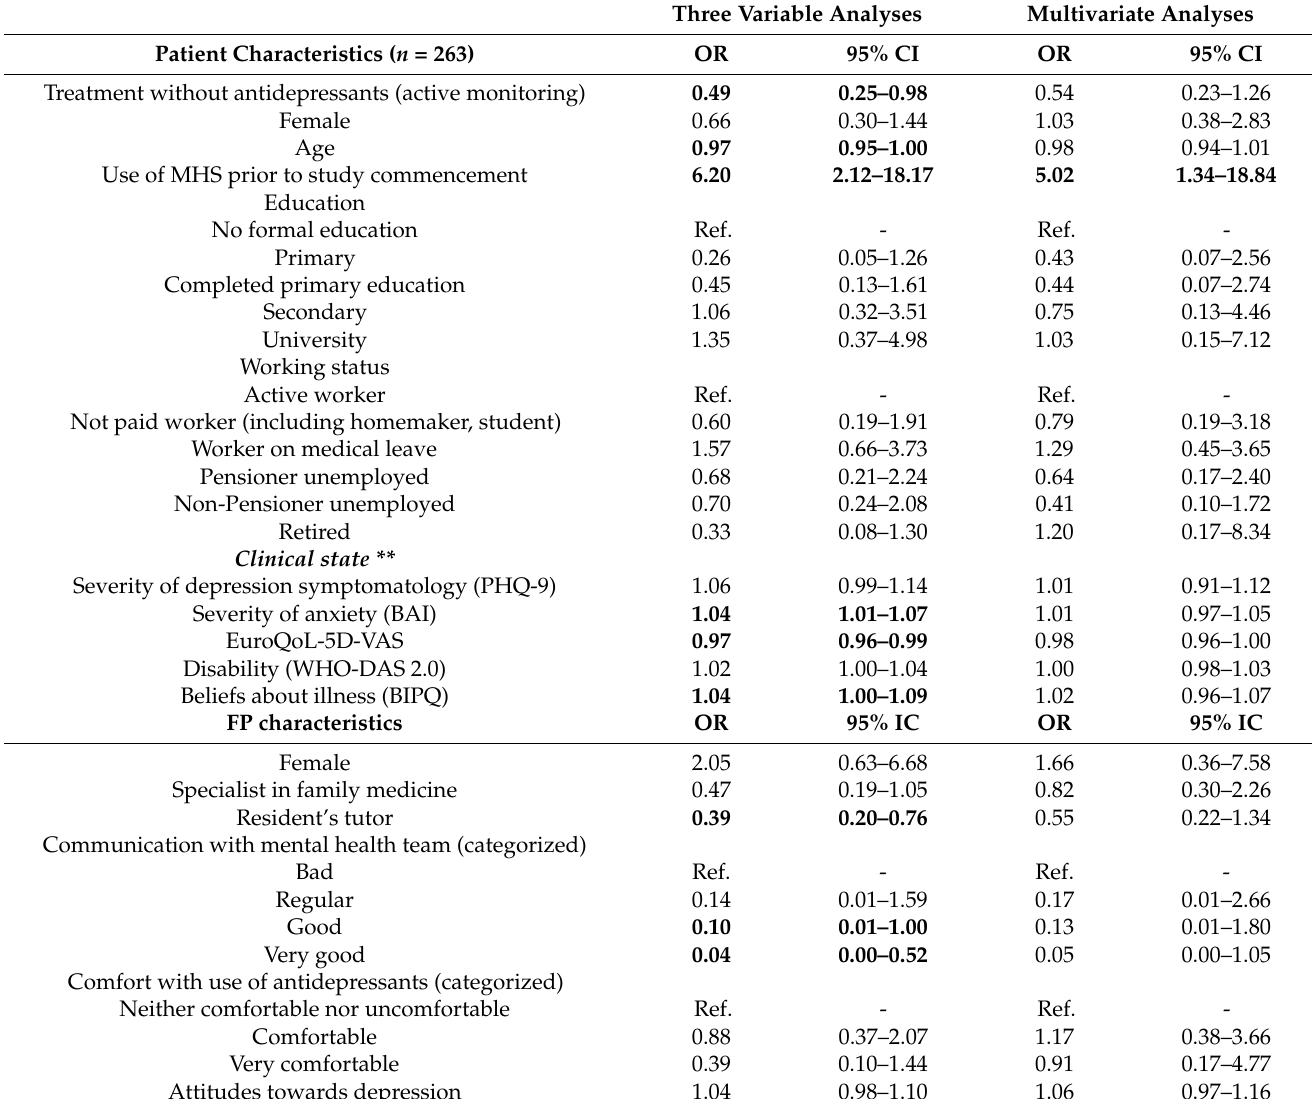
Table 2. Factors associated with use of public and/or private Mental Health Services (MHS) based on three variables and multivariate imputed multilevel logistic regression models